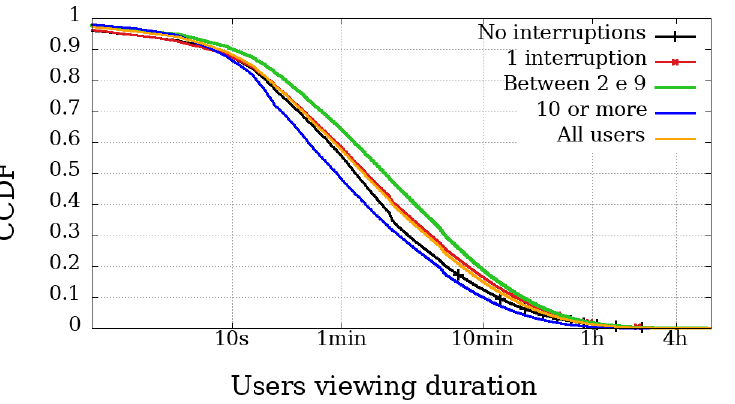
Figure 6. Complementary cumulative distribution function of the viewing duration from users, grouped by the amount of interruptions experienced in the transmission session of the Impeachment start session— Camara dos Deputados —mobile